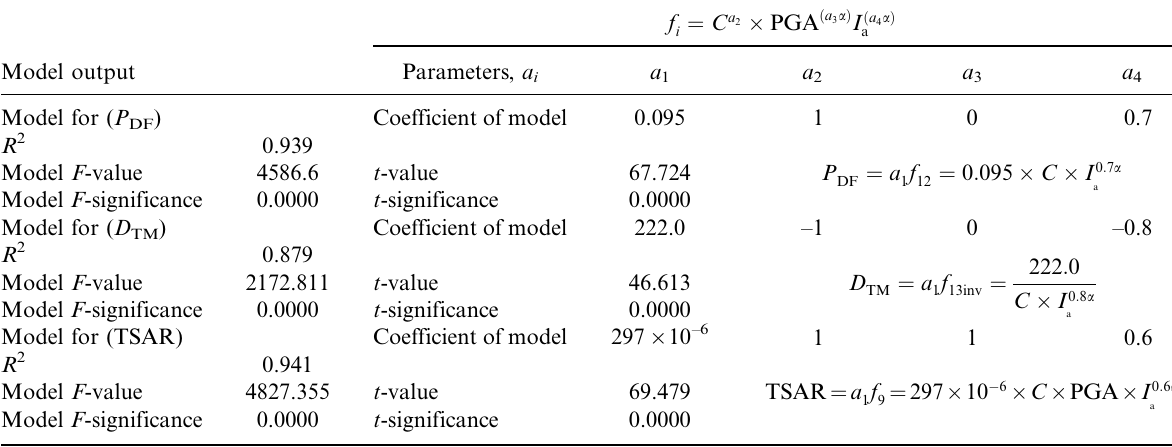
Table 10. Nonlinear regression output